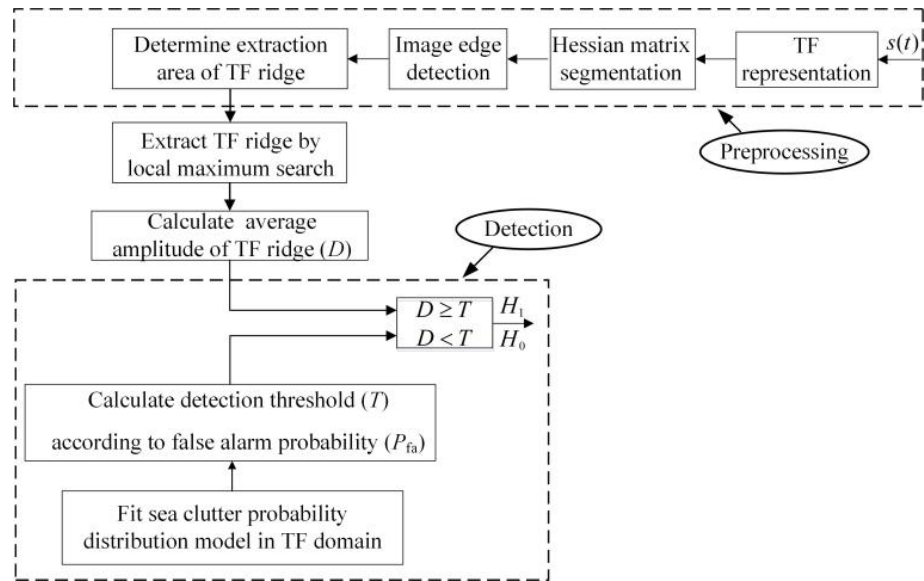
Figure 1. Flow chart for TF-CFAR.